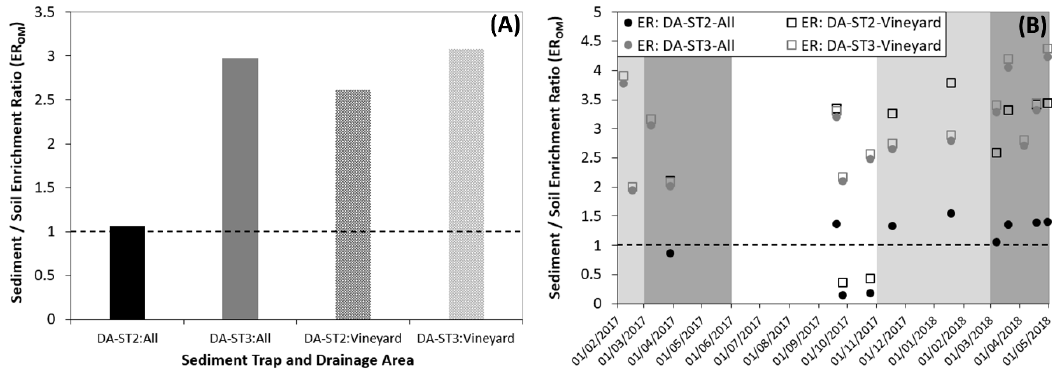
Figure 6. Mean sediment/soil organic matter enrichment ratio (ER OM ) in the ST2 and ST3 considering the whole drainage area or the drainage area within the vineyard ( A ). Evolution of the ER OM at TIP scale during the text period ( B ).